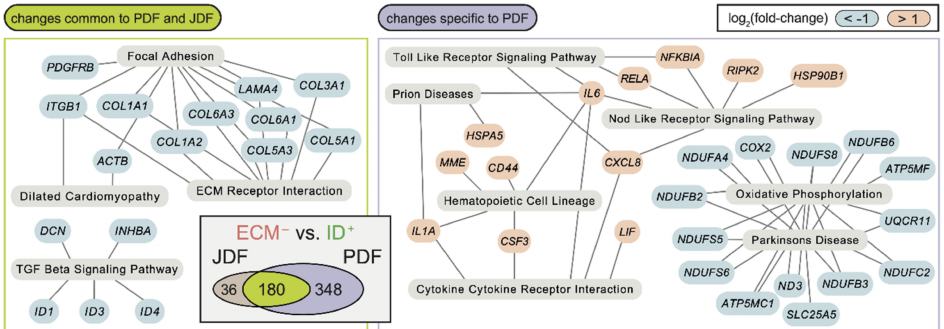
Figure 3. The di ff erences between the ECM − and ID + fibroblast clusters are largely replicated in PDF and JDF spheroids, with distinct features present in PDF fibroblasts. Changes common to both samples (left) are enriched in genes downregulated in ECM − clusters and participating in several KEGG pathways related to the extracellular matrix and TGF- β signalling. Changes specific to PDF spheroids (right) include hyperactivation of genes participating in cytokine signalling in the ECM − cluster. No KEGG pathway enrichment specific to the JDF sample was observed. The Venn diagram (inset) displays a significant overlap ( p < 10 − 6 , Fisher’s exact test) of di ff erentially expressed genes (false discovery rate FDR < 0.05, at least two-fold change in gene expression) in the comparison of the ECM − and ID + fibroblast clusters in JDF and PDF samples.